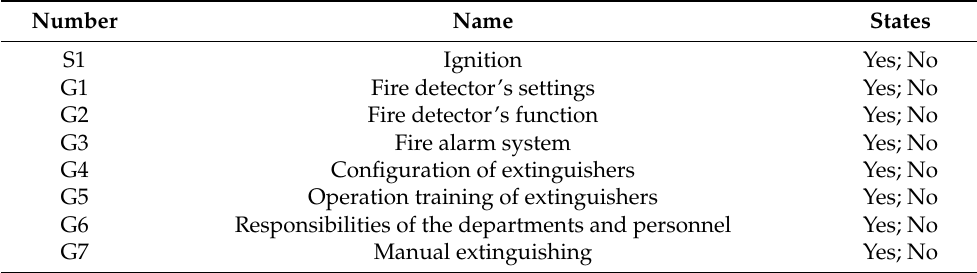
Table A5. The name and states of the nodes related to growth in Bayesian network.